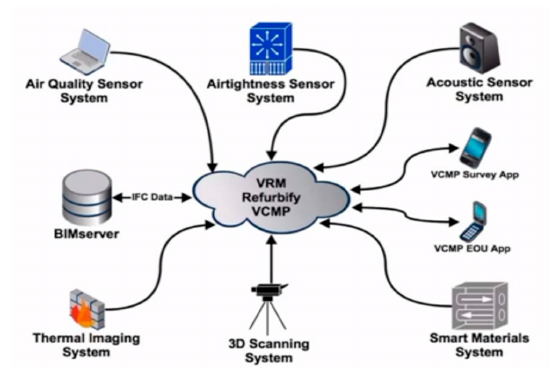
Figure 3. Representation of the VCMP and technology interaction identified in B2S